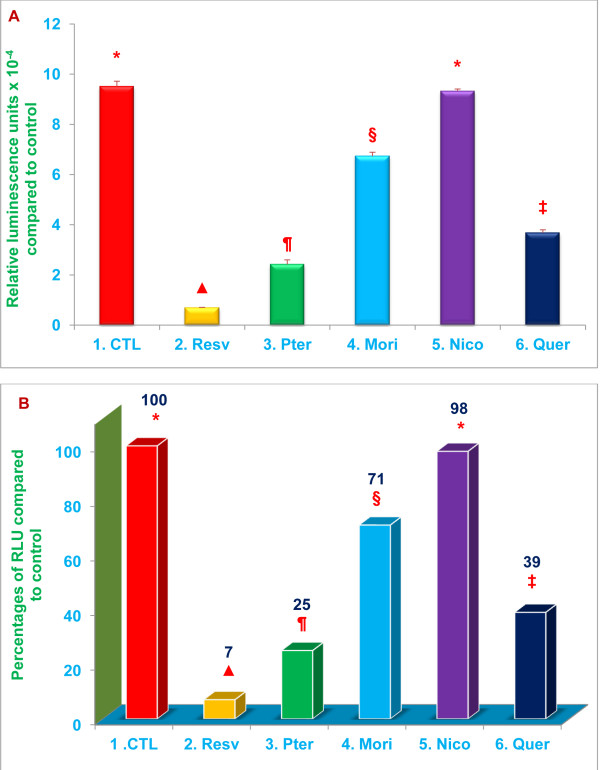
Resveratrol, pterostilbene, morin hydrate, and quercetin inhibit chymotrypsin-like proteasomal activity. Relative chymotrypsin-like activity was quantitated by measuring luminescence after treatment of RAW 264.7 whole cells (1x104 cells/well) with 20 μM of resveratrol, pterostilbene, morin hydrate, nicotinic acid, or quercetin. Cell viability exceeded 95% in all the treatments. Data are means ± SD, n = 3 per treatment, and triplicate analyses of each sample were performed. Values in a column not sharing a common symbol are significantly different at P < 0.05. CTL = Control (Medium + RAW 264.7 whole cells + 0.2 % DMSO); Resv = Resveratrol; Pter = Pterostilbene; Mori = Morin hydrate; Nico = Nicotinic acid; Quer = Quercetin-HCL. Figure A = Actual Relative Luminescence Unit (RLU) values. Figure B = Percentages of actual RLU values compared to control.